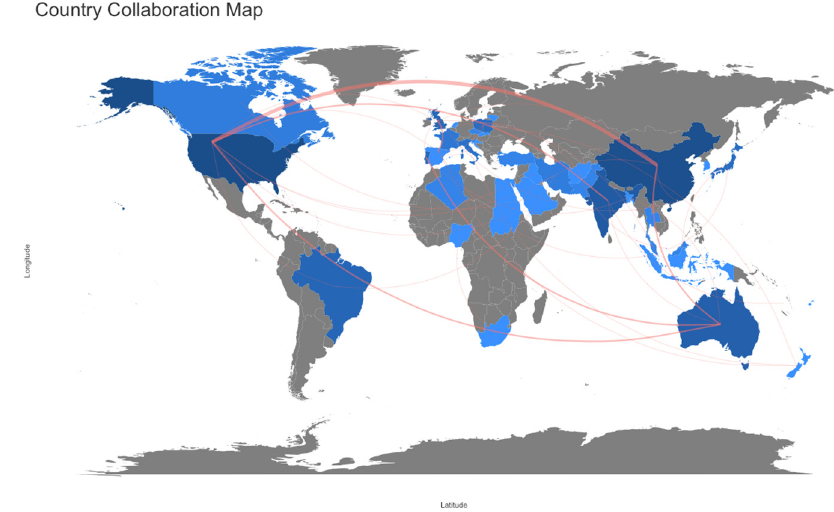
Figure 4. Countries’ scientific collaboration on geosyinthetics research entrenched with managerial implications, as considered in this study. The most collaborative countries have the darkest blue, the least collaborative have the lightest blue, while grey is for non-collaborative countries.